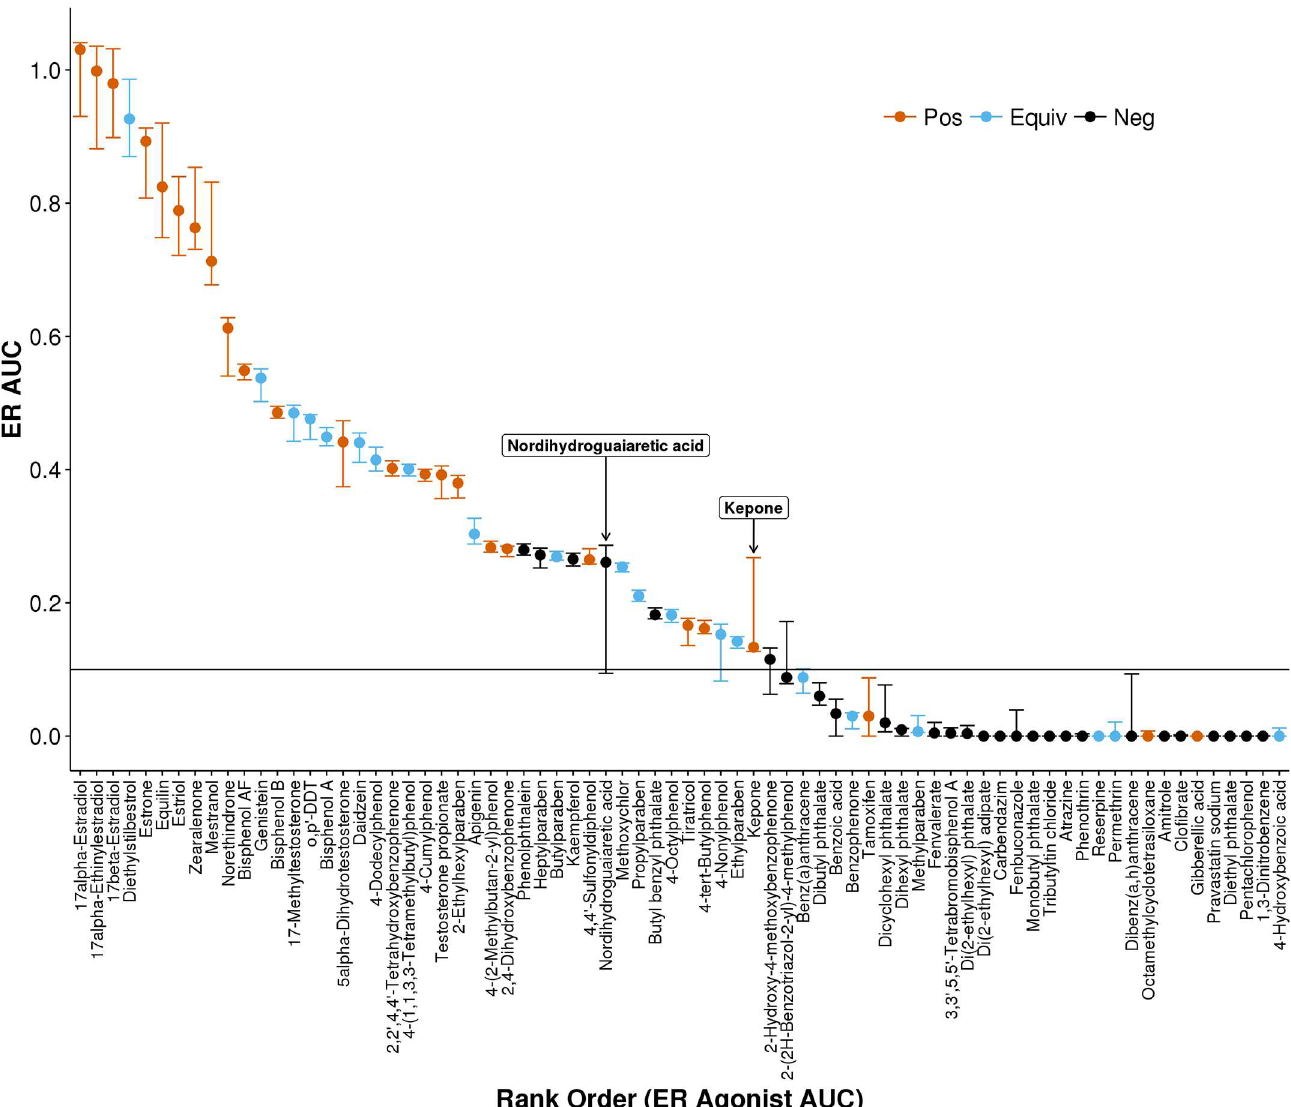
Fig 6. Estrogen receptor model agonist AUC values for chemicals tested at least twice in the uterotrophic assay. Point estimates for agonist are colored by the uterotrophic consensus result being positive (red), equivocal (blue), and negative (black). Equivocal results in the uterotrophic assay indicate some tests were positive while others negative. Error bars indicate the 95% confidence interval obtained by bootstrap